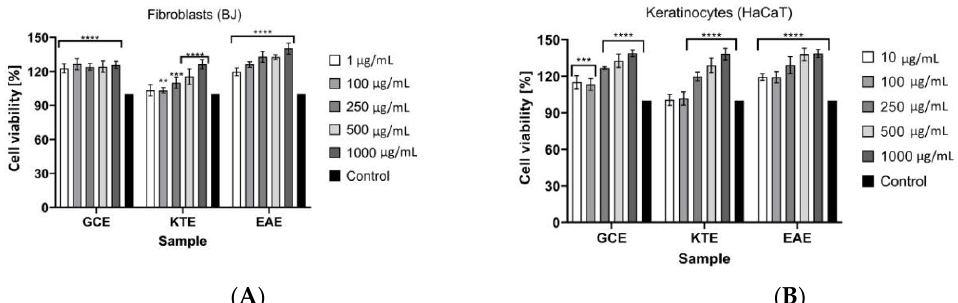
Figure 12. The reduction of resazurin after 24 h exposure to the Centella asiatica L. (GCE), Clitoria ternatea L. (KTE) and Epilobium angustifolium L. (EAE) extracts in cultured ( A ) fibroblasts (BJ) and ( B ) keratinocytes (HaCaT). Data are the mean ± SD of three independent experiments, each of which consists of three replicates per treatment group. For BJ **** p < 0.0001, *** p = 0.0001, ** p < 0.007 versus the control (100%). For HaCaT **** p < 0.0001, *** p = 0.0005 versus the control (100%).